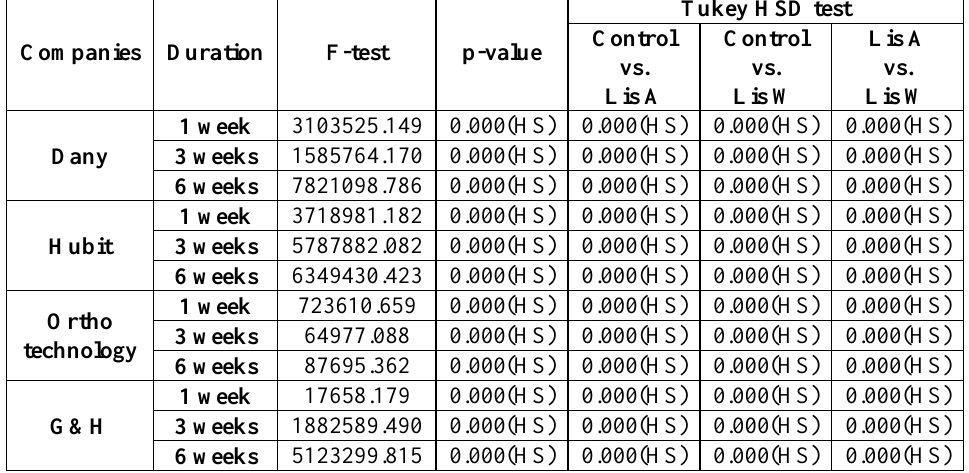
Table 3: ANOVA test and Tukey HSD test results of aesthetic arch wires and the effect of various immersion media. Companies